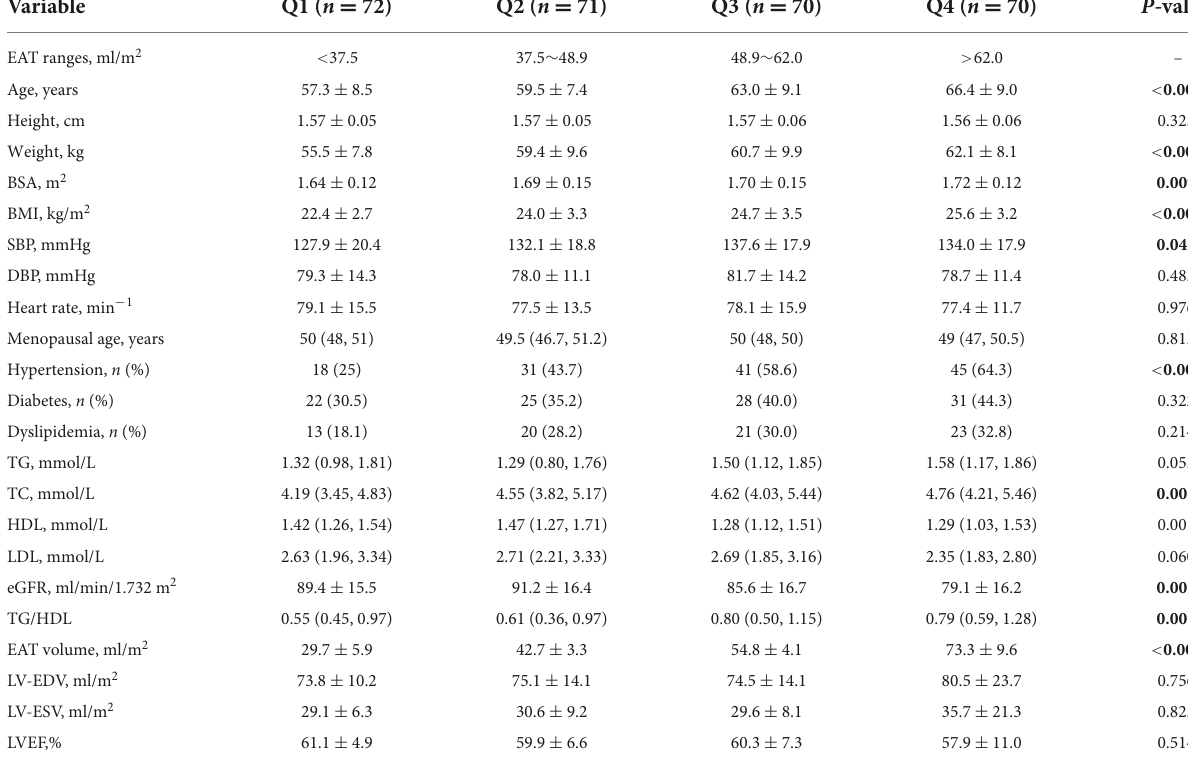
TABLE 1 Baseline characteristics of the included participants.